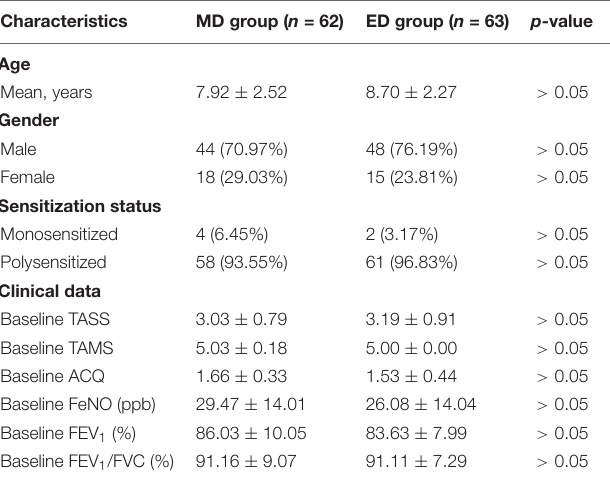
TABLE 1 | Characteristics of the study subjects. Data are presented as n (%) or Mean ± SD as appropriate. Characteristics